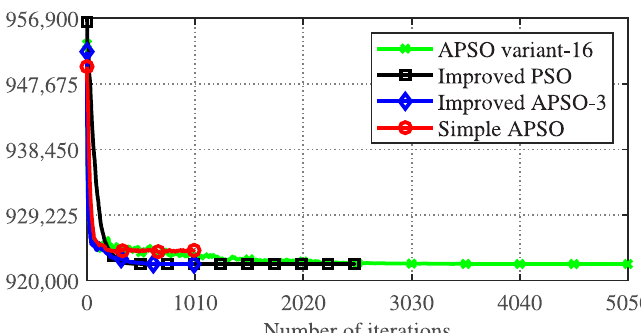
Fig 3. Comparison of the convergence behavior of the best trials of four metaheuristic algorithms on the CSTHTS problem.